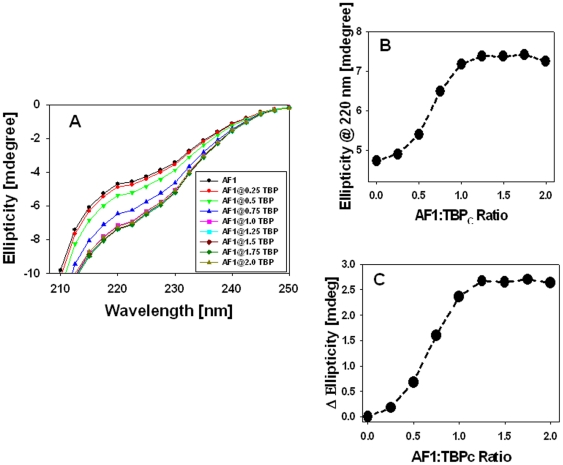
Secondary structural changes in AF1 when complexed with TBPC.
A) Far-UV CD spectra showing AF1 after subtracting the contribution of TBPC in each case. B) A plot ellipticity at 220 nm of AF1∶TBPC - TBPC with respect to AF1∶TBPC ratio. C) A plot of difference in the ellipticity at 220 nm of AF1∶TBPC - TBPC with respect to AF1∶TBPC ratio.